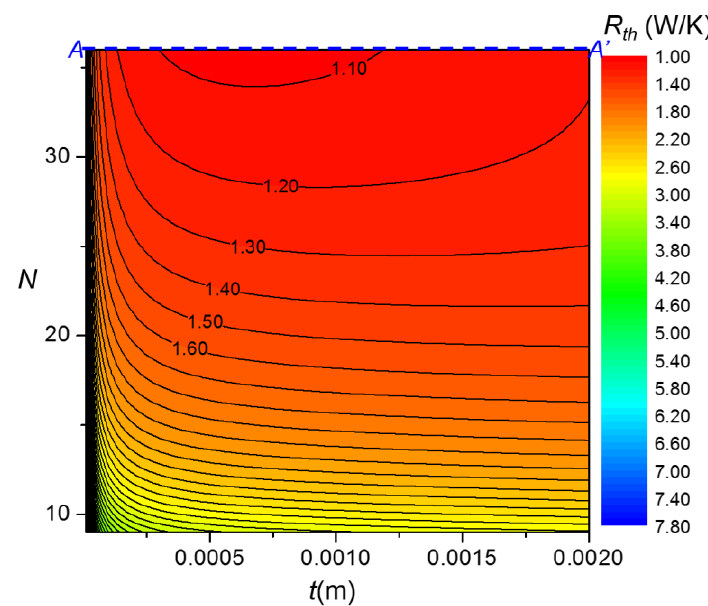
Figure 9. Contour map of thermal resistance for various fin numbers and fin thicknesses ( H = 30 mm, D = 60 mm, L = 50 mm, α = 60°, T w − T amb = 50 °C, k f = 0.026 W/m K, k s = 220 W/m K, ν f = 1.6 × 10 −5 m 2 /s, α f = 2.23 × 10 −5 m 2 /s, β f = 0.0033/K).